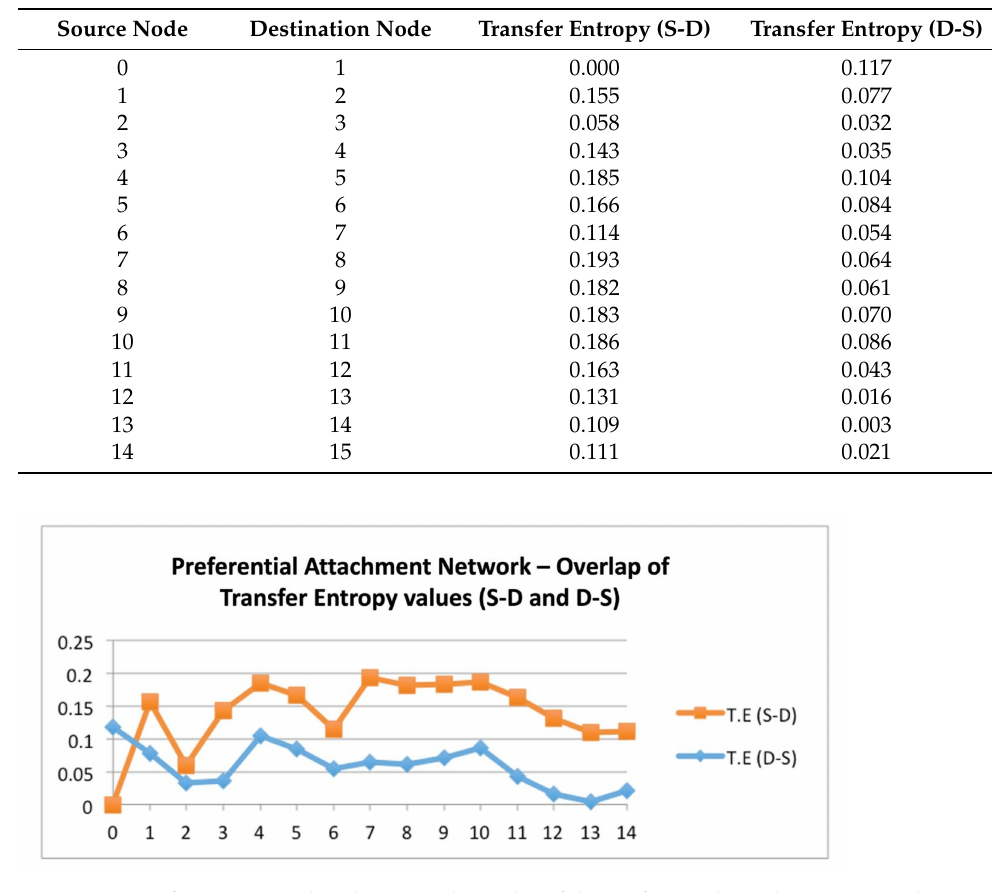
Figure 4. Transfer entropy values between the nodes of the preferential attachment